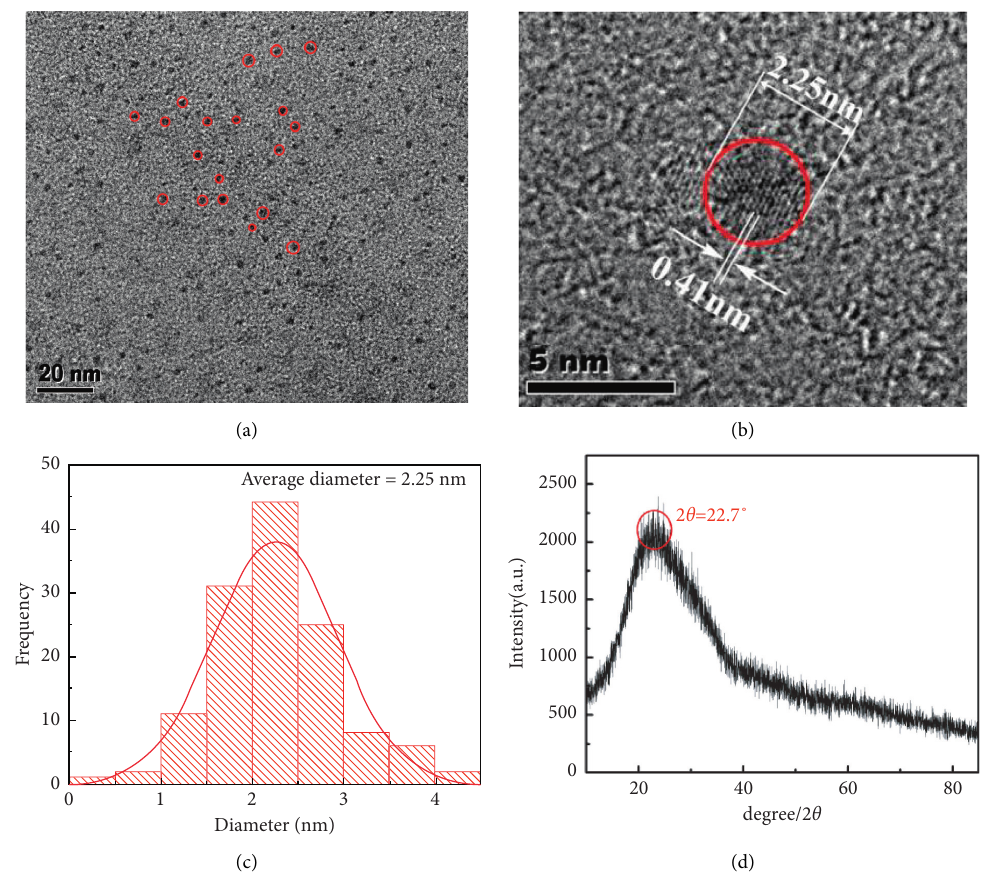
Figure 2: (a) TEM image of CQDs; (b) HRTEM image of CQDs; (c) Diameter distribution of CQDs; (d) XRD pattern of CQDs.